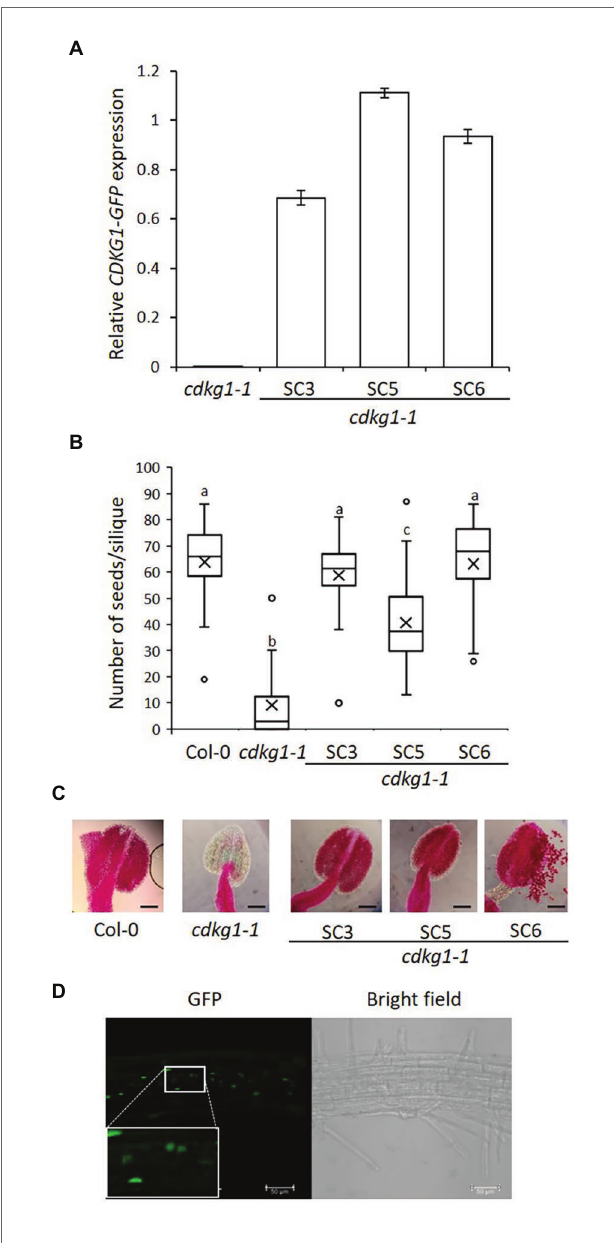
FIGURE 2 | The SC form of CDKG1 can rescue the cdkg1-1 mutant phenotype. (A) Expression levels of the CDKG1SC-GFP transcript as detected by qPCR in young inflorescences. Three independent lines expressing CDKG1SC-GFP in a cdkg1-1 background were tested. The cdkg1-1 mutant was used as a control. (B) Fertility counts of the transformed plants. The average number of seeds per silique was determined for Col-0, cdkg1-1 , and three independent lines expressing CDKG1SC-GFP under the control of the CDKG1 promoter in a cdkg1-1 mutant background. Data represent average and the interquartile range for 30 siliques from three plants. Superscript letters represent significance groups for p < 0.001. (C) Pollen viability staining of the lines above. Round carmine-colored pollen grains are viable, while white/blue shrunken pollen is not viable. Scale bar = 100 μ m. (D) The majority of the CDKG1SC-GFP protein is found in the nucleus of root cells in plants grown at 23 ° C and a small proportion observed in the cytoplasm. Images are single confocal sections. The GFP channel (green) and a bright field image are shown. Inset shows a magnification of the selected area. Scale bar = 50 μ